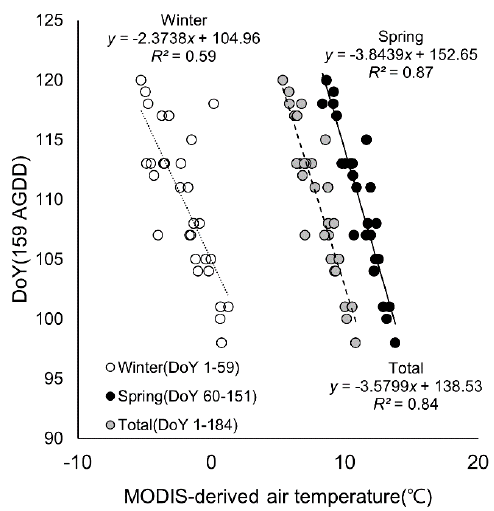
Figure 4. The relationship between mean moderate resolution imaging spectroradiometer (MODIS)-derived air temperature (winter: January to February, spring: March to May, total: January to June) and green-up DoY AGDD for 30 sampling sites of Mongolian oak forests in South Korea. Green-up start dates from MODIS-derived AGDD in 2015 and EVI in 2000, 2005, 2010, and 2015 were closely related with each other (Figure 5). Green-up start dates from MODIS-derived EVI in 2000, 2005, 2010, and 2015 were also closely related with each other (Figure 6). Another comparison was carried out to establish the relationship between the seasonal mean air Remote Sens. 2020 , 12 , x FOR PEER REVIEW temperature measured from meteorological stations (N = 93; Figure 1) and the green-up DoY determined by the AGDD threshold derived from measured air temperature. The result indicated that the seasonal mean air temperatures were significantly related to the green-up DoY ( p ≤ 0.01) (Figure 7). Among the results compared, the coefficient of determination was the highest in the winter season (R 2 = 0.78), followed by the whole season (R 2 = 0.75), and the spring season (R 2 = 0.65).